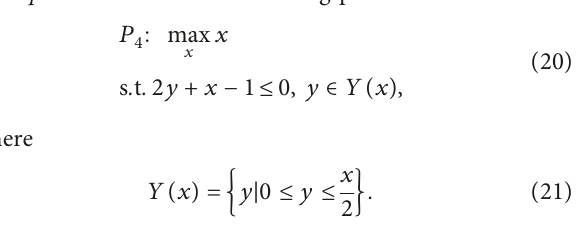
Figure 1: Feasible set of P